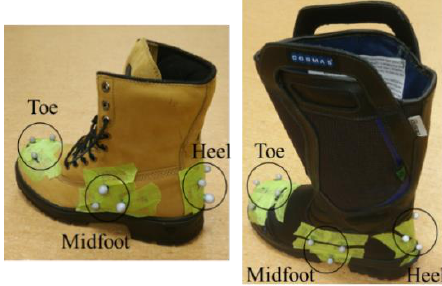
Figure 6. Motion capture markers attached to the F1 ( left ) and F5 ( right ).